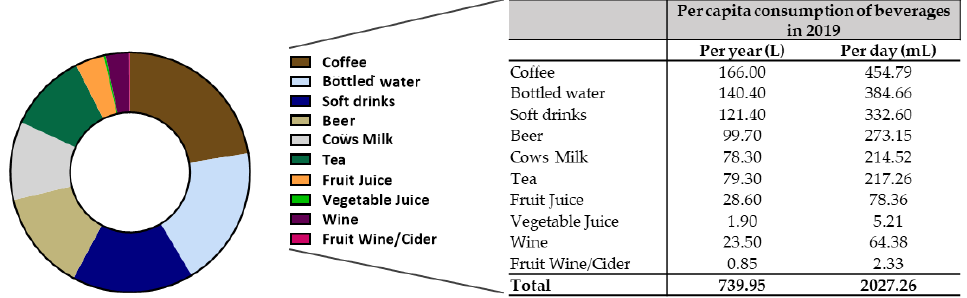
Figure 3. Published per capita consumption of beverages in Germany in 2019 [11–13]. Note: spirits, although depicted here, have not been further analyzed due to their low daily consumption.